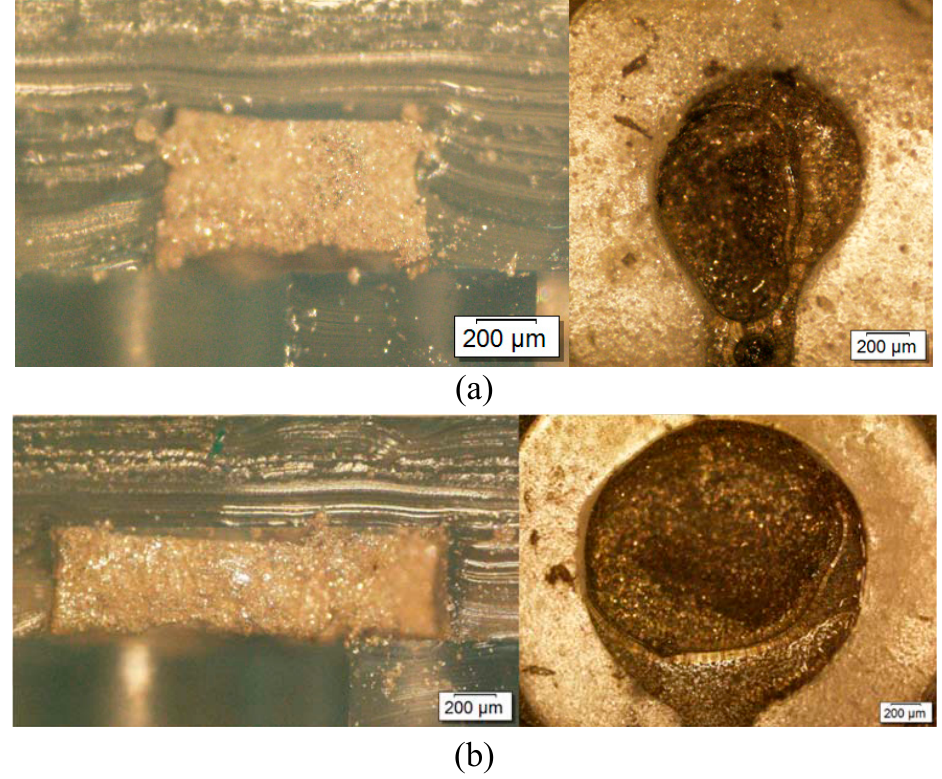
Figure 8. Cross-sectional and frontal views of electrode with a surface area of ( a ) 0.785 mm 2 and ( b ) 3.14 mm 2 .